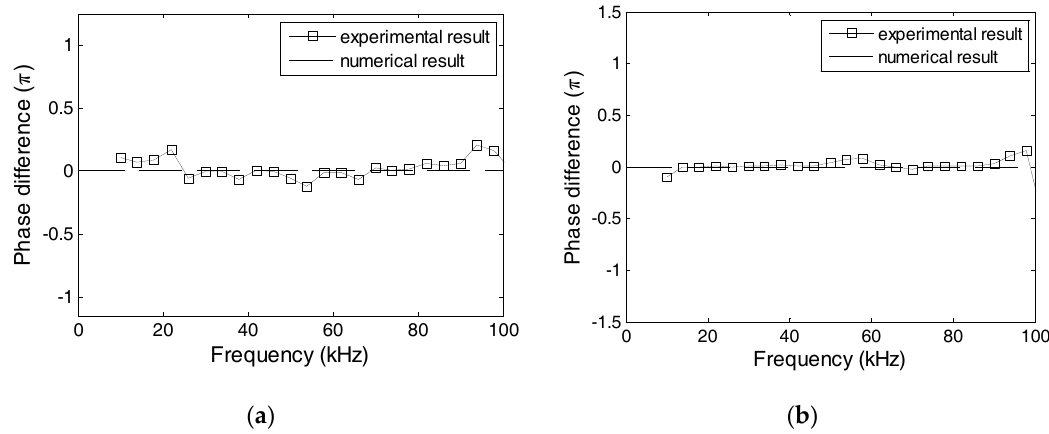
Figure 25. Phase difference between PZT-1 and PZT-2 for Specimens 7 and 8. ( a ) Specimen 7; ( b ) Specimen 8.